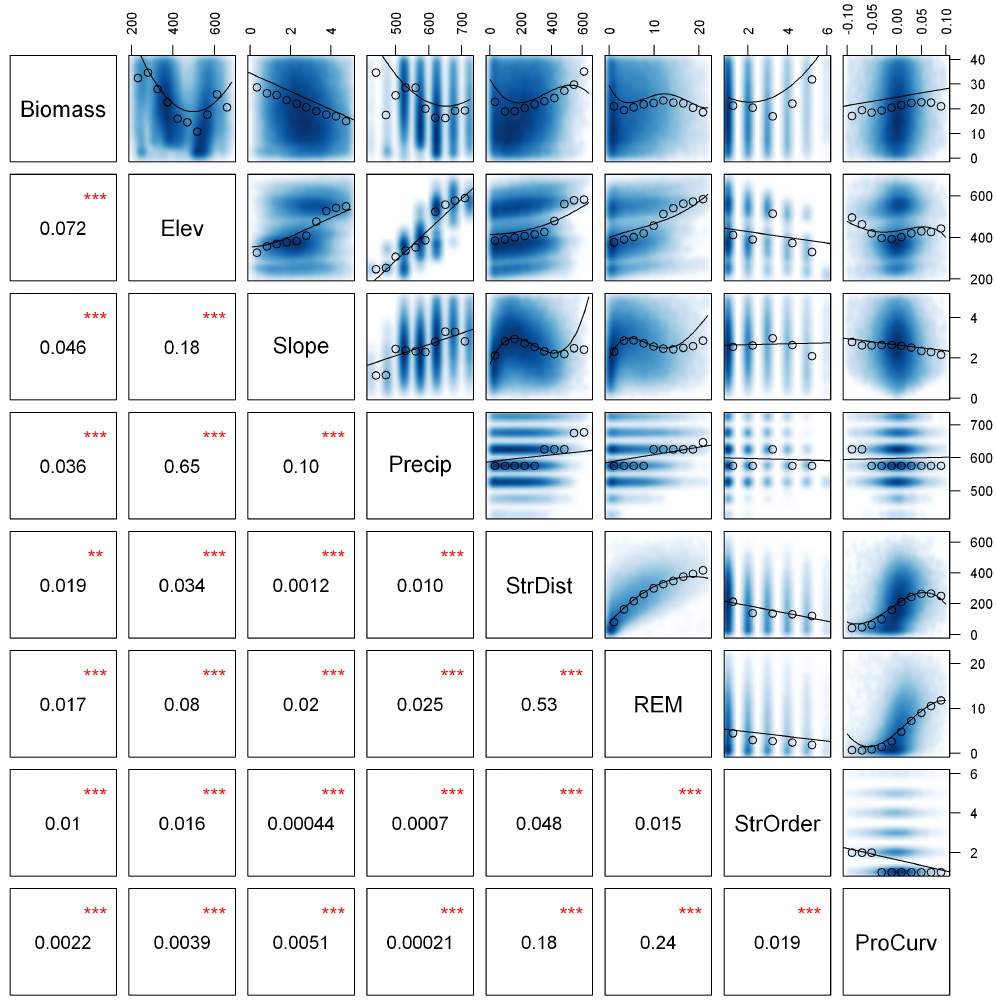
Fig. 6. Interactions between biomass and landscape factors. Top row indicates correlation of LiDAR-derived AGB to landscape variables for n =82503 CAO biomass pixels (0.5 ha/pixel) on southern granite substrate. All other rows indicate interactions between landscape factors. Blue intensity indicates point density of the raw data. Curves are the most parsimonious models fit to the raw data. Circles are median values sampled at set intervals to visualize underlying patterns in the raw data (blue). Numbers in lower-left half are R 2 for the model curve shown in the corresponding scatter plot, and stars indicate statistical significance (** p < 0.01, *** p < 0.001) but not necessarily ecological relevance. Landscape factors shown are: elevation above sea level (m), slope (deg), precipitation (mmyr − 1 ), distance from nearest stream (m), relative elevation model (height above nearest stream) (m), stream order, and profile curvature (positive values are convex)